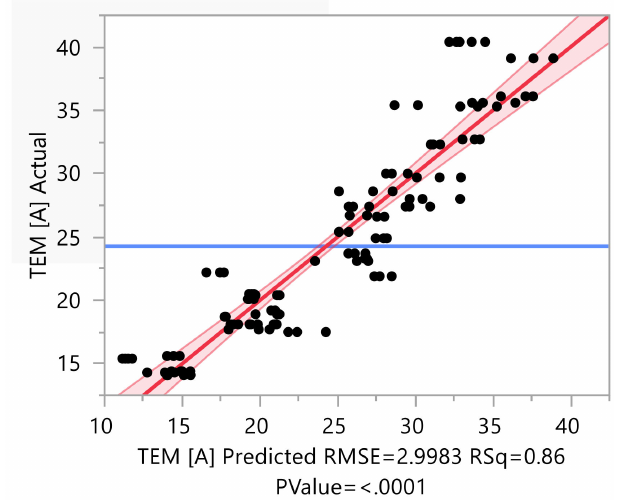
Figure 5. Model prediction results for Equation (1), with parameters: a 0 = 23.68; a 1 = 0.86; a 2 = − 19.31; a 3 = 19.00; a 4 = −